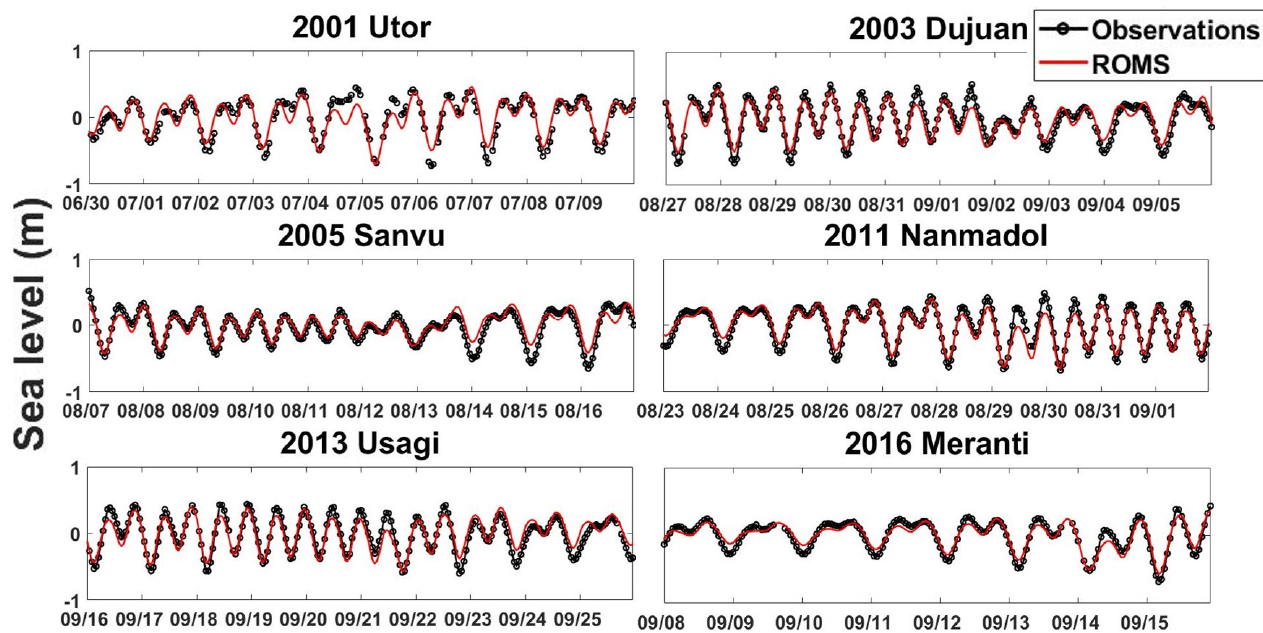
Figure 3. Sea-level changes derived from ROMS model simulations (red lines) and tidal gauge measurements at the Longdong tide station (25.098° N, 121.918° E, https://ocean.cwb.gov.tw/V2/data_interface, black circle lines) (accessed on 20 March 2021). during 6 typhoon passages.